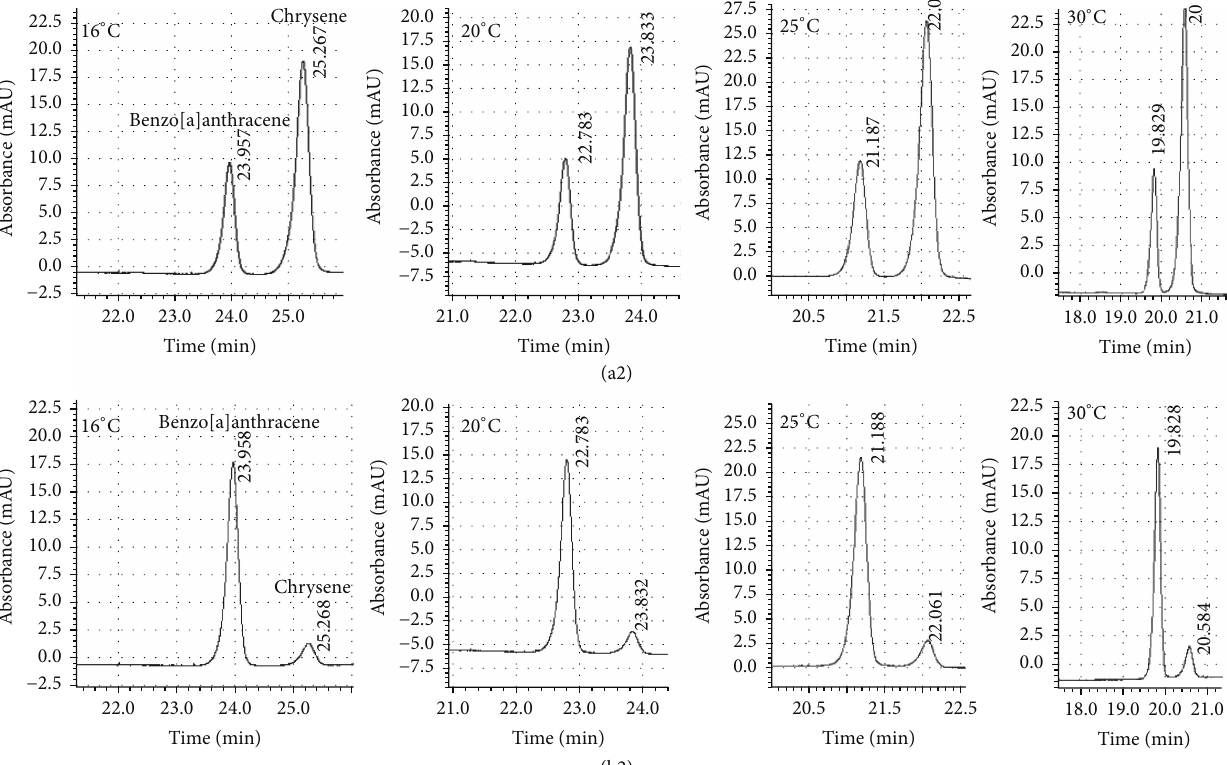
Figure 6: Influence of column temperature on the separation of chrysene and benzo[a]anthracene using the Spherisorb column; (a2) at 266 nm; (b2) at 286 nm.